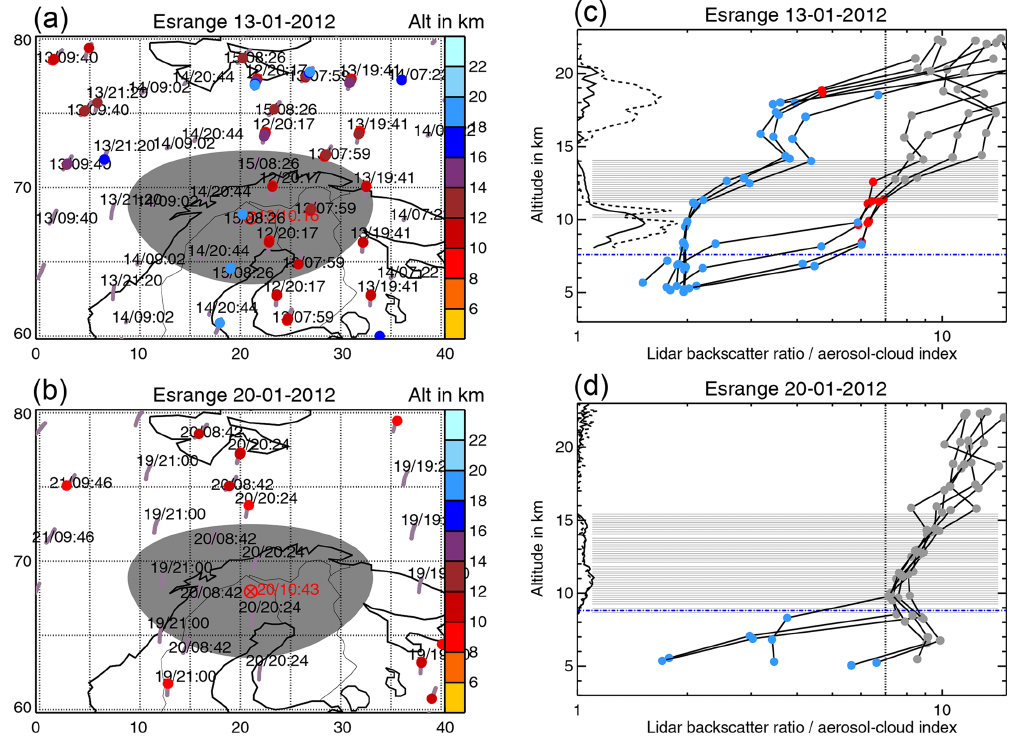
Figure 13. Nabro aerosol measurements over Esrange on (a, c) 13 January 2012 and (b, d) 20 January 2012. (a, b) Maps with lidar station, lidar measurement time, match radius, MIPAS orbits, MIPAS profile measurement time, and MIPAS cloud top heights (colour coded). (c, d) MIPAS ACI profiles and lidar backscatter ratio profiles. The grey areas denote the aerosol layer measured by the lidar, the black solid line is the parallel backscatter ratio, and the black dashed line is the perpendicular backscatter ratio. In the MIPAS ACI profiles the grey dots denote clear air, red dots sulfate aerosol, and blue dots denote ice and optically thick clouds. The black dotted line is the ACI threshold of 7. Table 8. Nabro sulfate aerosol measured by the Esrange lidar and MIPAS. For the lidar data aerosol layer top and bottom are given. For MIPAS, the number of matching profiles, the mean cloud top height, and the corresponding minimum and maximum top heights are given. Profile Date Lidar MIPAS top